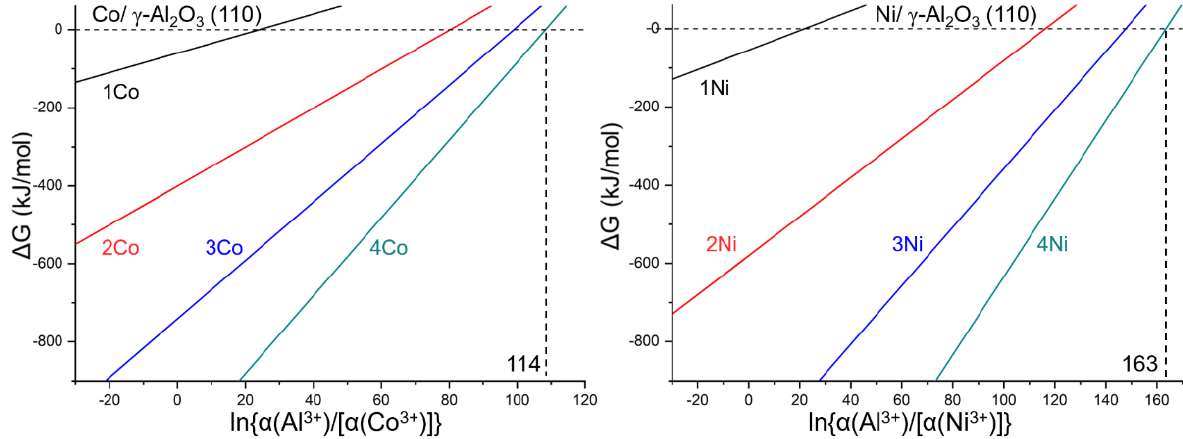
Figure 4. The function of substitution reaction free energy change ( Δ G ) of ln[α(Al 3+ )/α(Me 3+ )] under 300 K in the Equation (3).